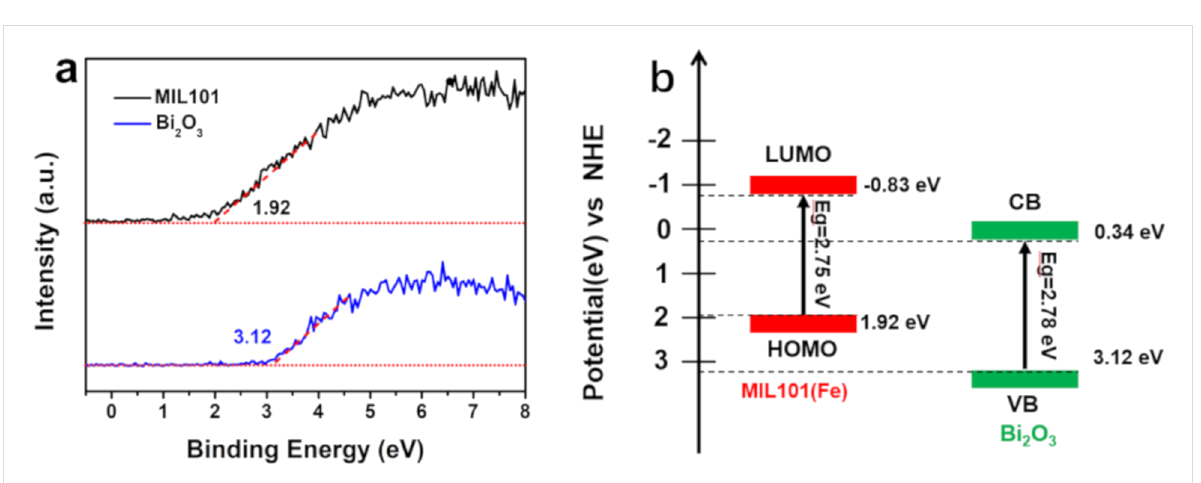
Figure 9: (a) The VB-XPS spectra and (b) the energy band position of Bi 2 O 3 and MIL101(Fe).